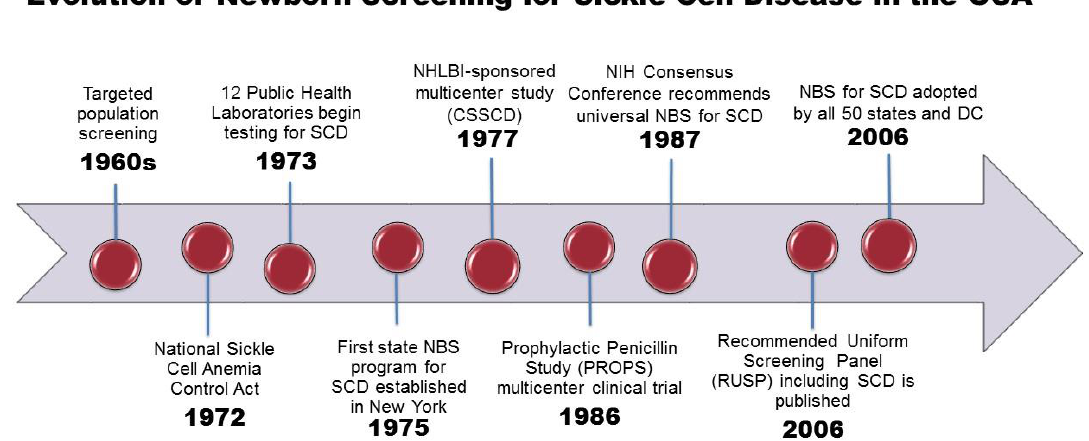
Figure 1. SCD includes Hb SS, Hb S/beta thalassemia and Hb SC genotypes. Abbreviations: ACMG, American College of Medical Genetics; CSSCD, Cooperative Study of Sickle Cell Disease; HHS, Health and Human Services; HRSA, Health Resources and Services Administration; NBS, newborn screening; NHLBI, National Heart, Lung and Blood Institute; NIH, National Institutes of Health; RUSP, Recommended Uniform Screening